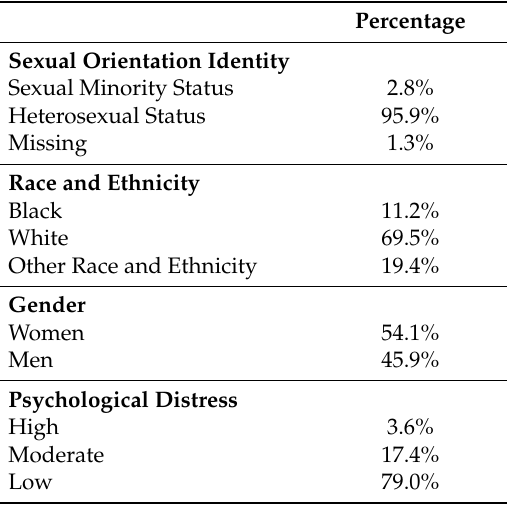
Table 1. Weighted percentages of sexual orientation identity, race and ethnicity, and psychological distress, 2013–2017 National Health Interview Survey.